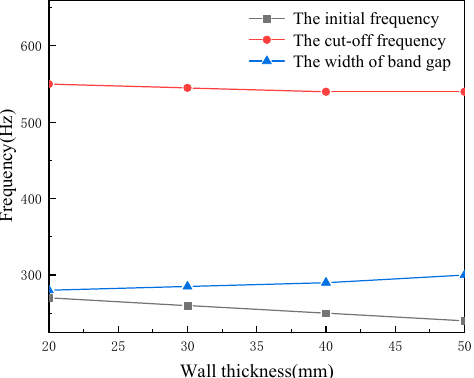
Figure 6. The effects of local resonant wall thickness on the band gap.